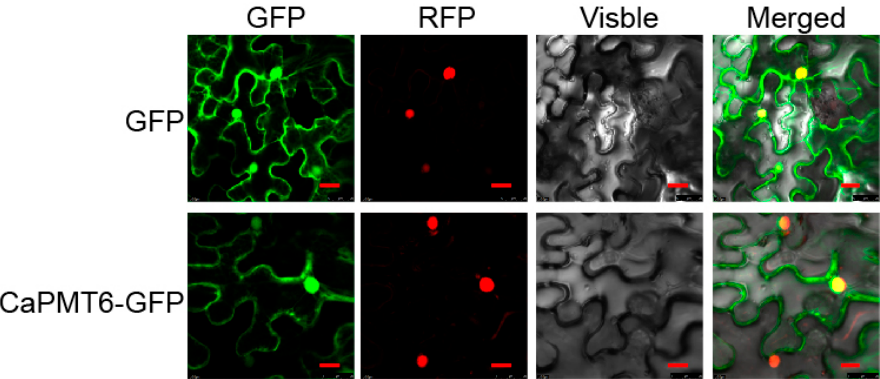
Figure 4. Subcellular location of CaPMT6 in epidermal cells of N. benthamiana leaves. N. benthamiana leaves were infiltrated with Agrobacterium GV3101 cells containing 35Spro:CaPMT6-GFP (using 35Spro:GFP as control); we used NbH2B (histone H2B)-RFP to indicate the nucleus. Subcellular localization of the CaPMT6-GFP fusion protein or control GFP was captured on a fluorescent confocal microscope at 48 hpi. Fluorescence images, bright-field images, and the corresponding overlay images of representative cells expressing GFP or CaPMT6-GFP fusion protein are shown; Bars = 50 µ